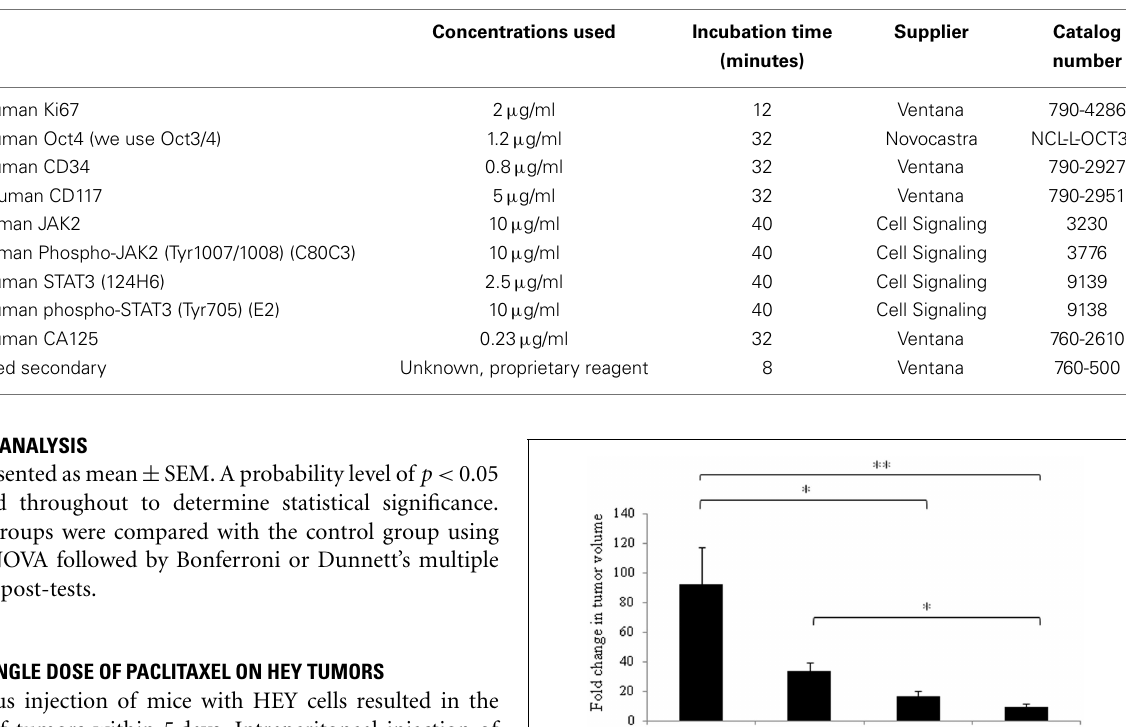
Table 2 |Antibody information.